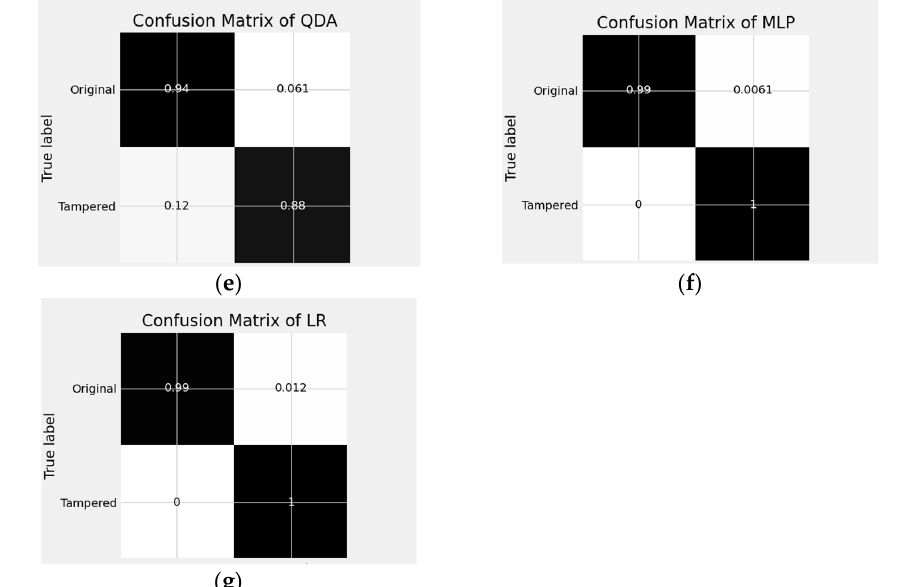
Figure 12. Confusion Matrix of The Proposed Machine Learning Model for Binary Classification